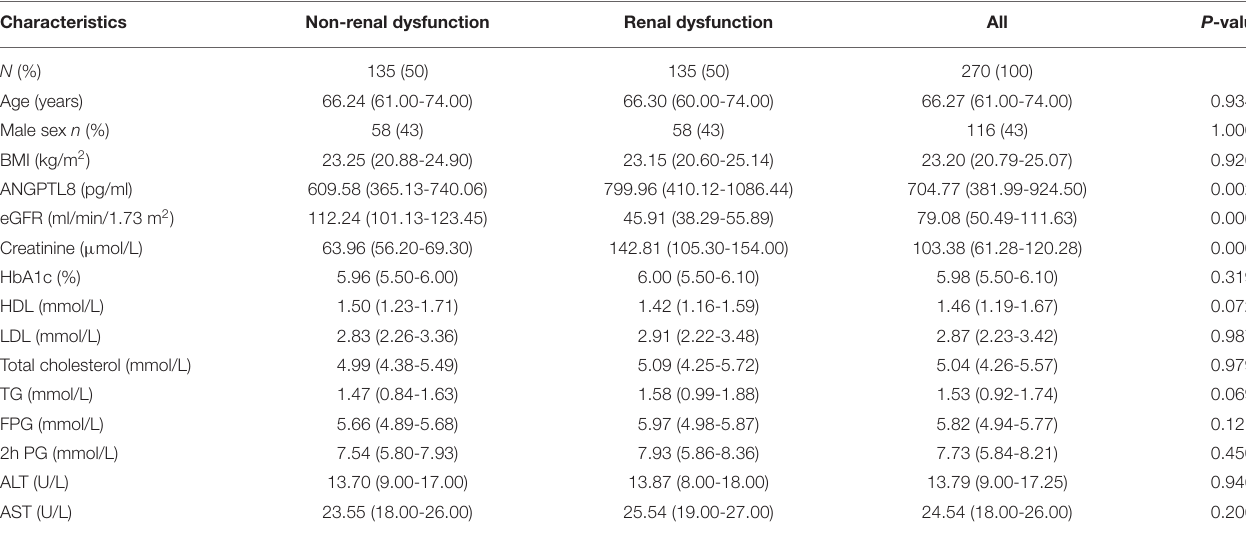
TABLE 1 | Clinical and biochemical parameters for non-renal dysfunction subjects and renal dysfunction patients.